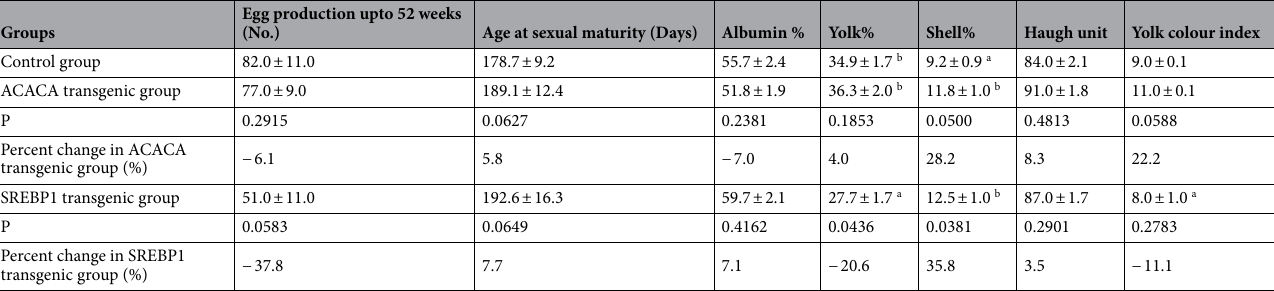
Table 8. Egg production (Mean ± standard deviation) upto 52 weeks and egg quality traits (Mean ± standard deviation) at 52 weeks of age in transgenic (n = 2 for ACACA transgenic group and n = 2 for SREBP1 transgenic group) and control birds (n = 2) during 1st generation. Different superscripts (column-wise) indicate significant differences at P < 0.05. The internal egg quality traits viz. albumin%, yolk%, shell%, Haugh unit and yolk colour index at 52 weeks of age were measured in egg quality testing machine in both transgenic and control groups. Yolk% and shell% of eggs between transgenic and control groups differed